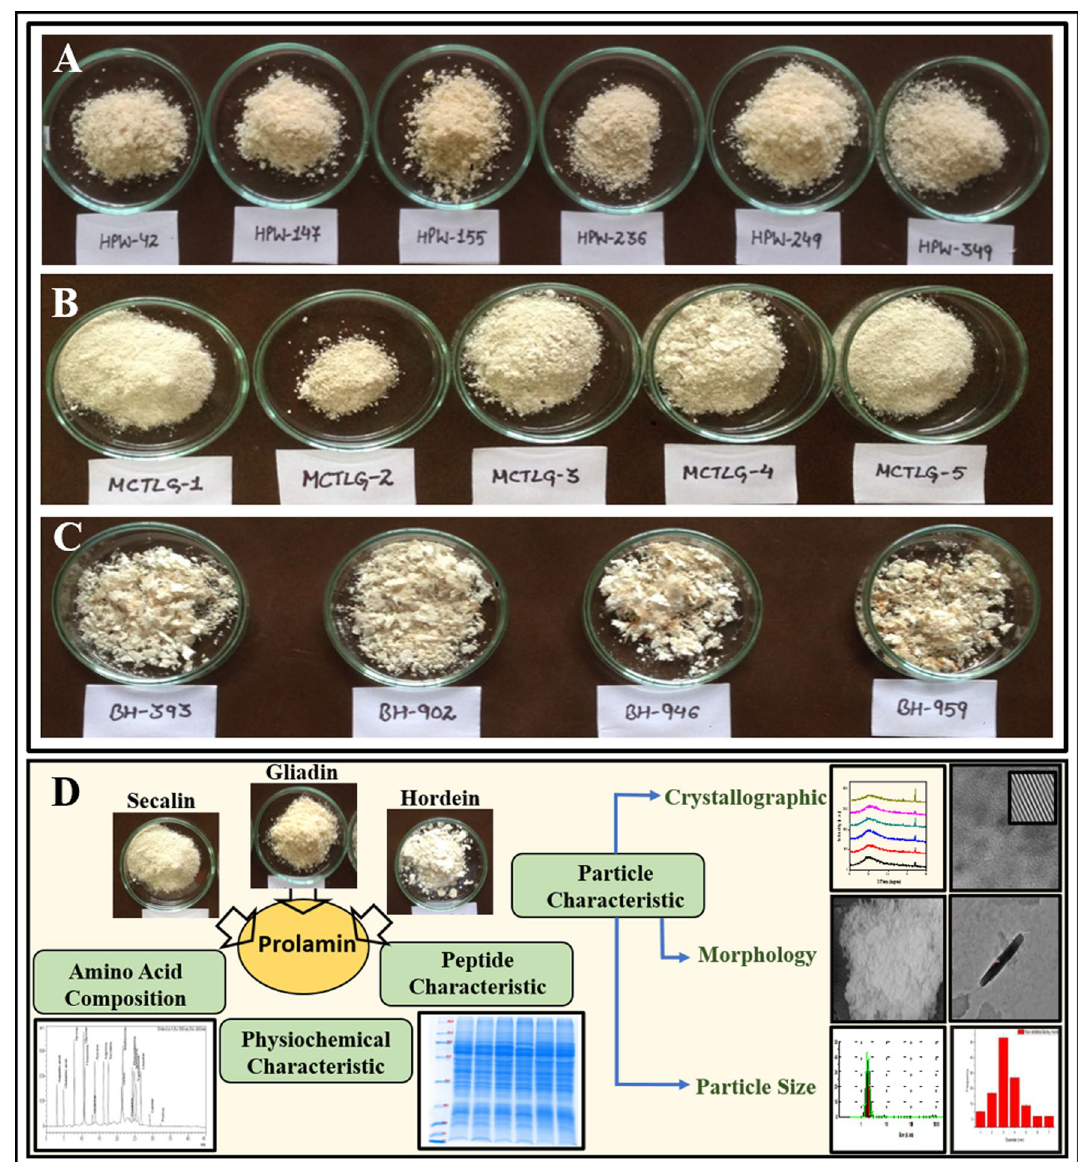
Figure 1. Images of prolamin freeze-dried powder ( A ) Gliadin, ( B ) Secalin and ( C ) Hordein extracted with DuPont et al., (2005) extraction protocol. While ( D ) represents graphical representation of the investigations conducted on prolamin fraction from wheat, rye and